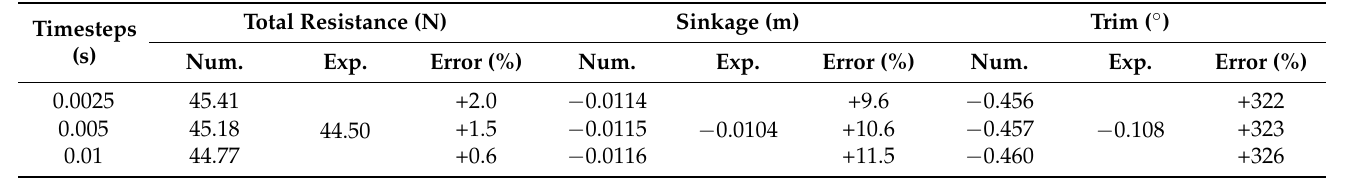
Table 6. Total resistance, sinkage and trim obtained by three time steps for intact ship ( Fr = 0.28).